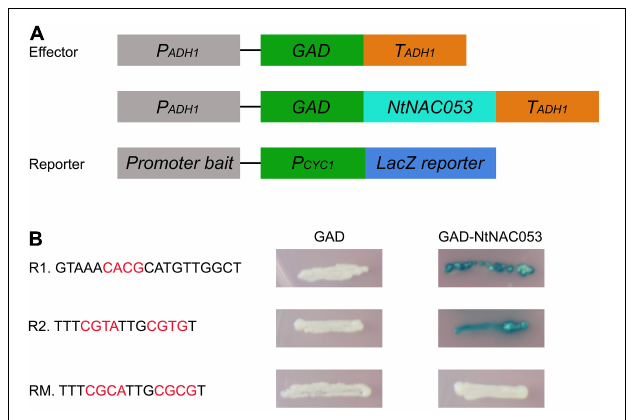
FIGURE 10 | Binding activity of NtNAC053. (A) Diagrams illustrating the structure of reporter and effector constructs. (B) The sequence of the NACRS (R1 and R2) and mutated NACRS (RM). Different combinations of effector and reporter constructs were co-expressed in yeast strain YM4271.